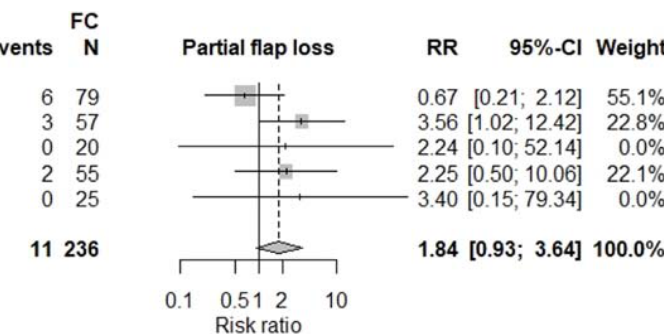
Figure 4. Postoperative infection.